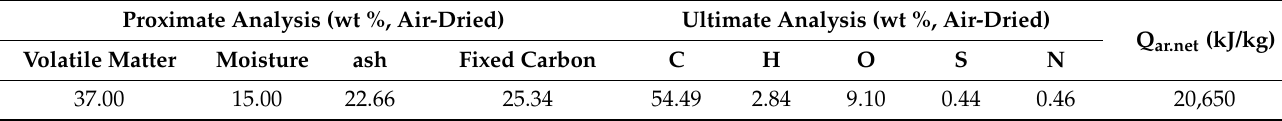
Table 2. Proximate and ultimate analyses of the coal sample.